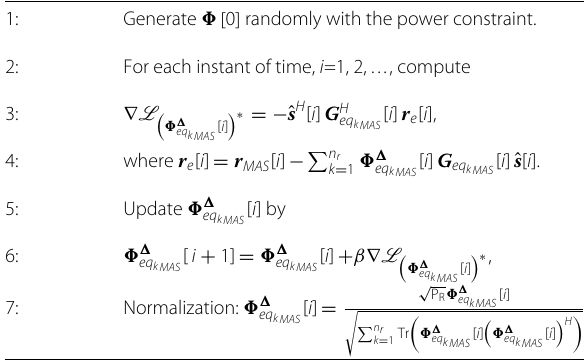
Table 2 Summary of the DT-ACMO SG algorithm in